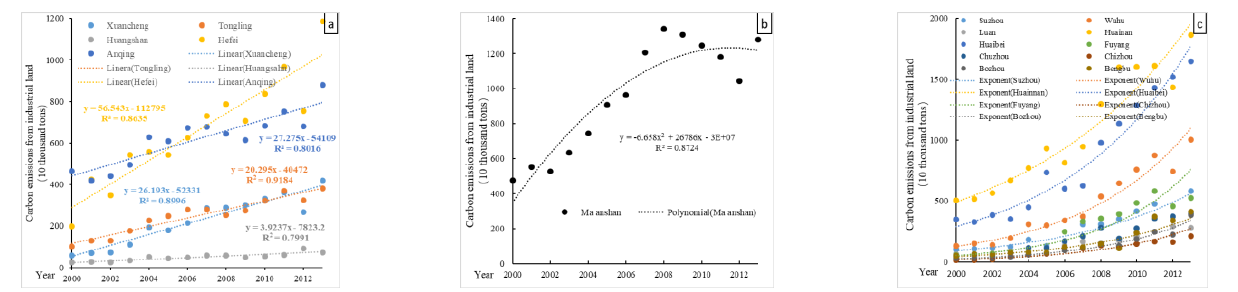
Figure 6. Changes in CEIL in 16 prefectural cities in Anhui Province from 2000 to 2013: ( a ) a linear growth trend; ( b ) a polynomial growth trend; and ( c ) an exponential growth trend. Table 3. Changes in the ICEI of prefecture-level cities in Anhui Province from 2000 to 2013. Unit: ton/ ten thousand